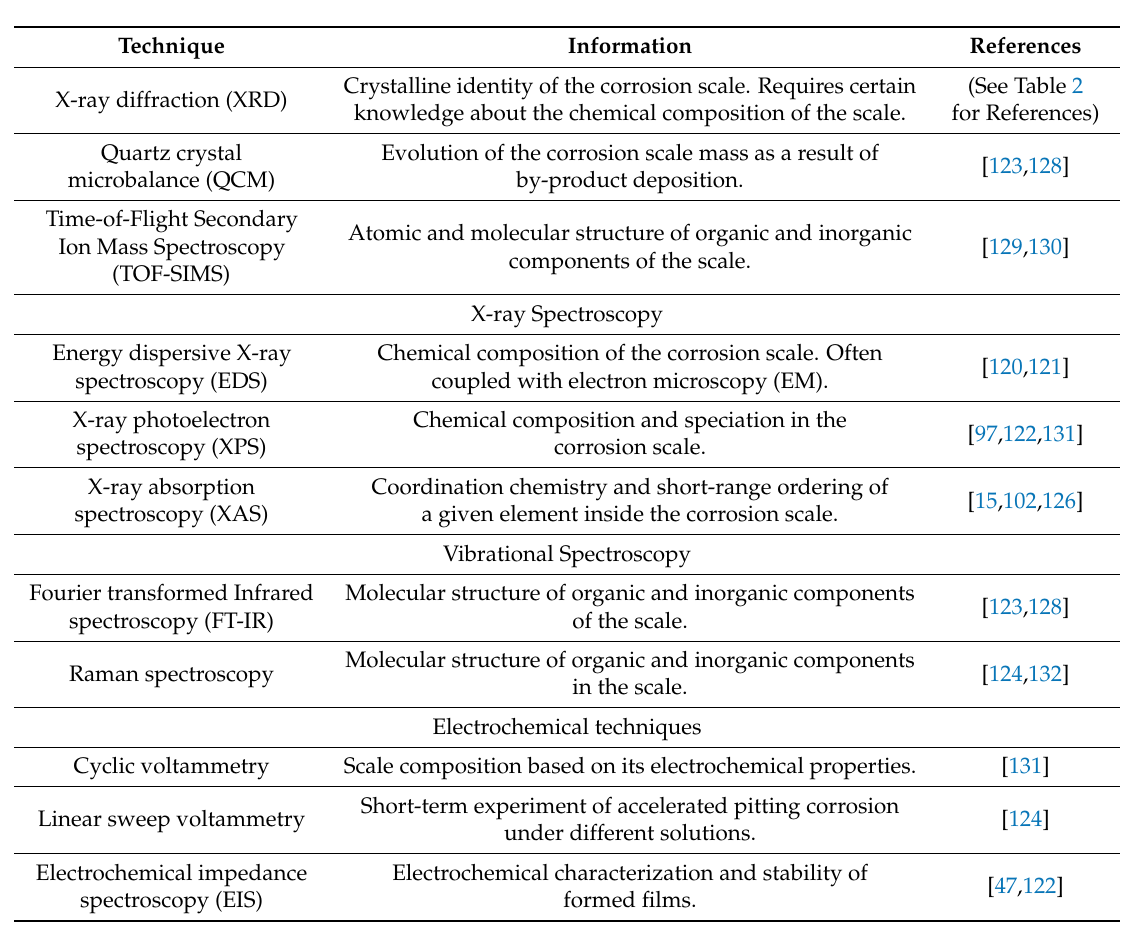
Table 3. Summary of available techniques to study the identity and composition of solid by-products formed during copper corrosion